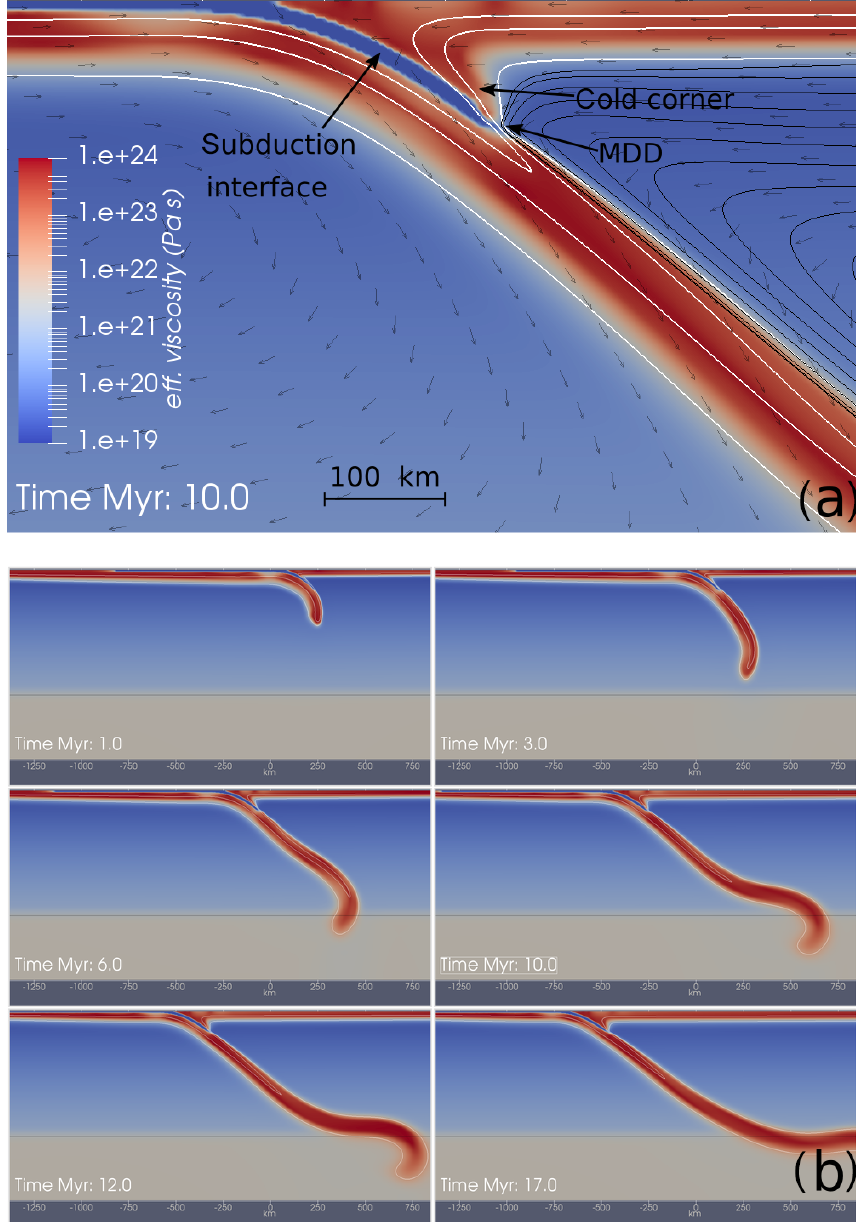
Figure 1. Example of dynamic subduction simulation. Colour map shows the effective viscosity on a logarithmic scale, and reveals the weak finite-width subduction interface which enables the decoupling of the slab and the upper plate. The implementation of the interface follows a modified WL approach, which we refer to as an embedded fault (EF). The subduction interface extends to 100km depth, beyond which the slab and mantle become coupled (MDD). Above the MDD, part of the mantle wedge tends to become stagnant due to the strong temperature dependence of the rheology. This is often referred to as a cold corner. (a) Closeup of slab in the upper mantle. White contour lines show 400, 700, and 1200 ◦ C isotherms. Black lines are streamlines of the velocity in a fixed upper plate reference frame. Arrows show model velocity field. (b) Time evolution of the same model, showing slab rollback and interaction with the transition zone.